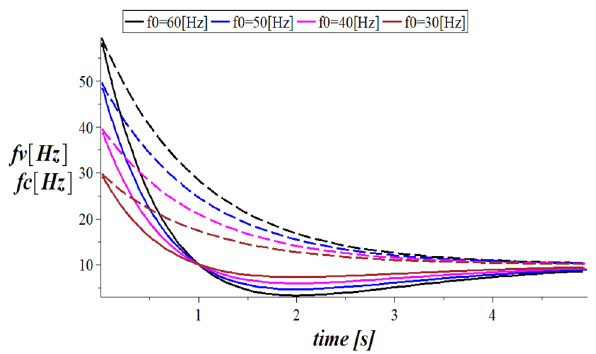
Fig. 14 Presentation of exponential decrease of voltage frequency f 10 (Hz) – dash lines, and t ) , from f 60,50,40,30 (Hz) to f k = v 3 ( 0 = respective frequencies of current f c 3 ( t ) – solid lines; T = 0.075 (s)